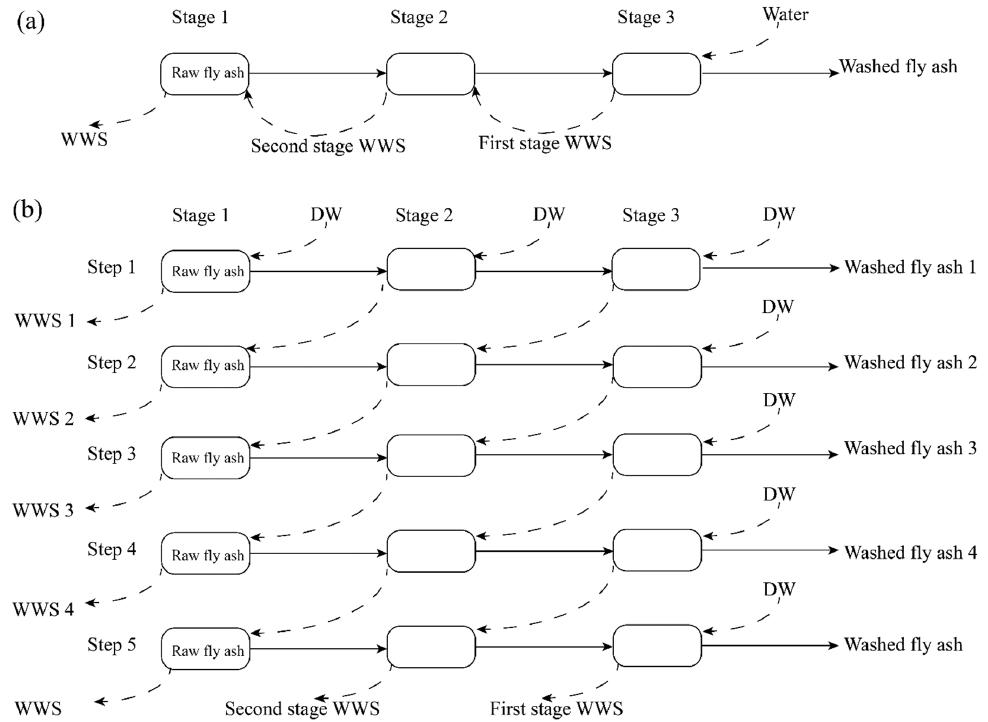
Figure 2. Circulating procedure and experimental procedure: ( a ) circulating procedure; ( b ) experimental procedure.